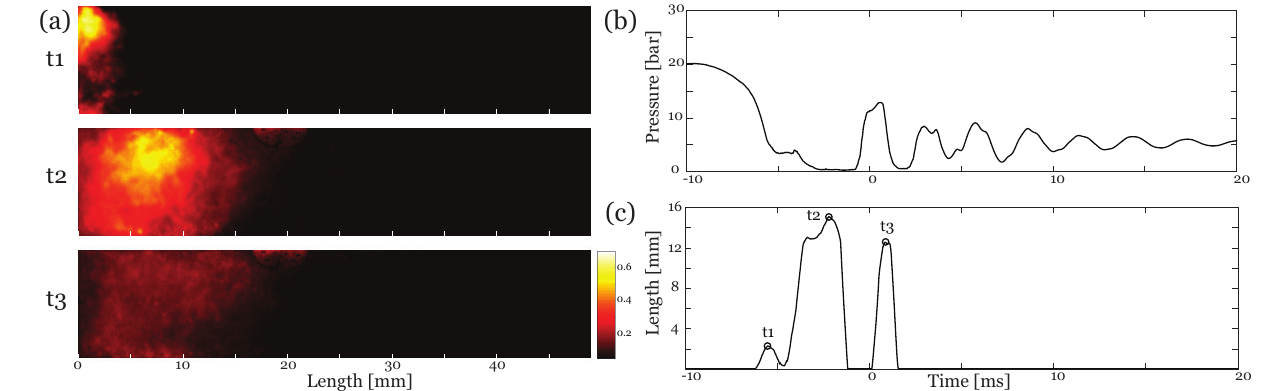
Figure 8. Column separation length for Re = 1633. ( a ) Ensemble-averaged vapor distribution for N = 5 tests at different snapshots (see t1–t3 in ( c )). Vapor intensity range [ 0.05,0.7 ] . For camera settings, see Table 2. ( b ) Ensemble-averaged pressure at P1 pressure sensor. ( c ) Column separation after valve closing.